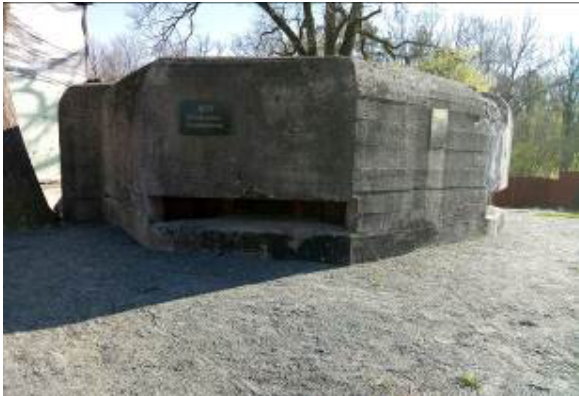
Figure 5. Machine gun pillbox №